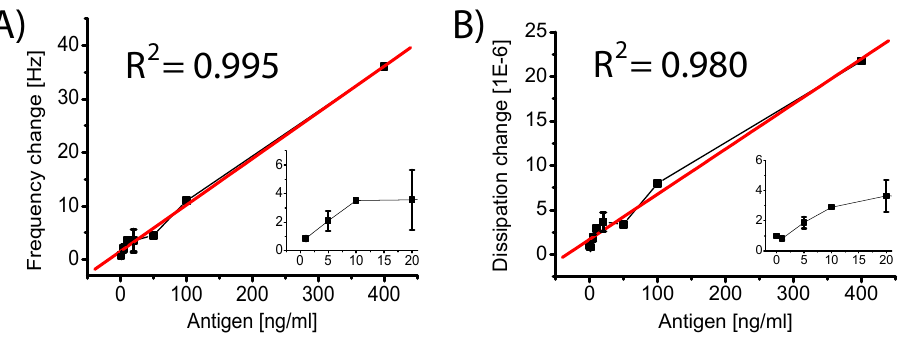
Figure 3. Vesicle adsorption for low antigen concentrations. A: Frequency change upon adsorption of the vesicles as a function of the antigen concentration. B: Dissipation change upon adsorption of the vesicles as a function of the antigen concentration. The insets show the detection limit at low